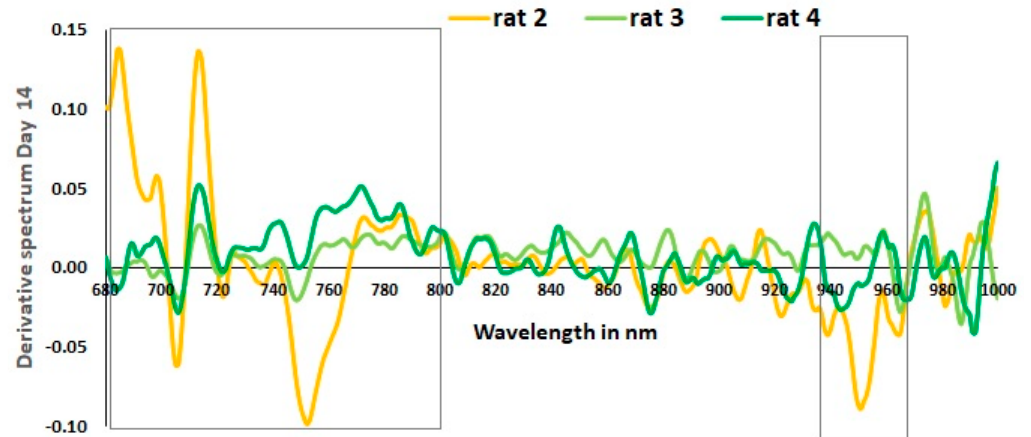
Figure 6. In vivo results. Derivative spectra plotted from one measurement of day 14. It is plotted for all three rats that survived until day 14. Rat 2 has significant peaks compared to the other two rats between the wavelengths 680 nm and 800 nm, suggesting issues related to blood flow on the implantation site highlighted using the first box. The abnormal skin rash in rat 2 influenced the optical measurements near 955 nm compared to rats 3 and 4, highlighted using the second box.